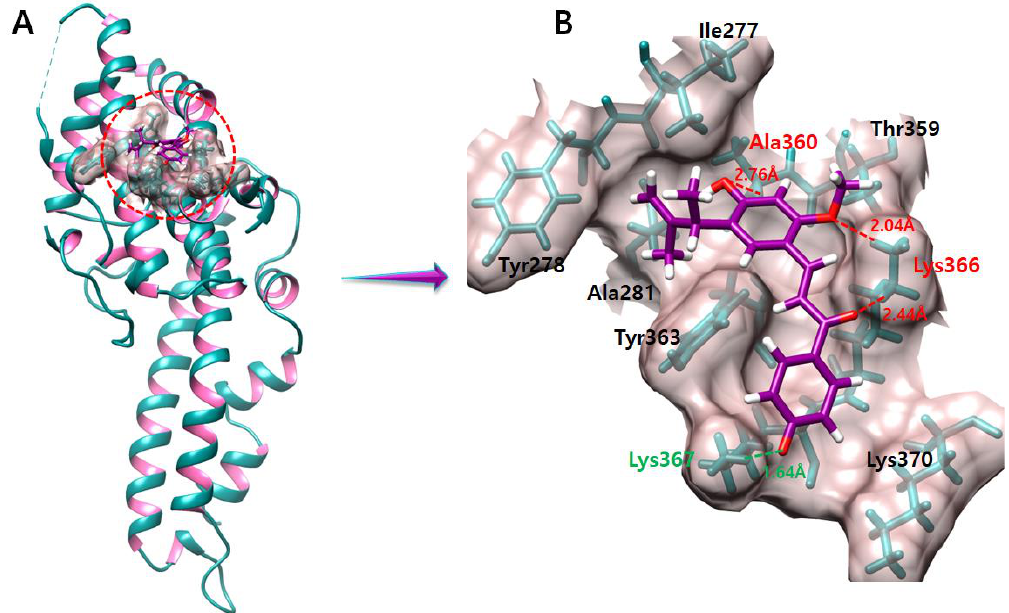
Figure 8. The figure ( A ) shows the licochalcone E and DBP complex. The salt bridges and hydrogen bonds produced during our docking experiment are shown in green and red color, respectively in Figure ( B ). The liquiritigenin molecule forms two hydrogen bonds with Lys366 and Gln356 res- idues. The oxygen atom of liquiritigenin forms a hydrogen bond with Lys366 with a length of 1.89 Å , while another oxygen atom of liquiritigenin forms a hydrogen bond with Gln356 with a length of 1.92 Å (Figure 9) in the active region of the targeted protein.